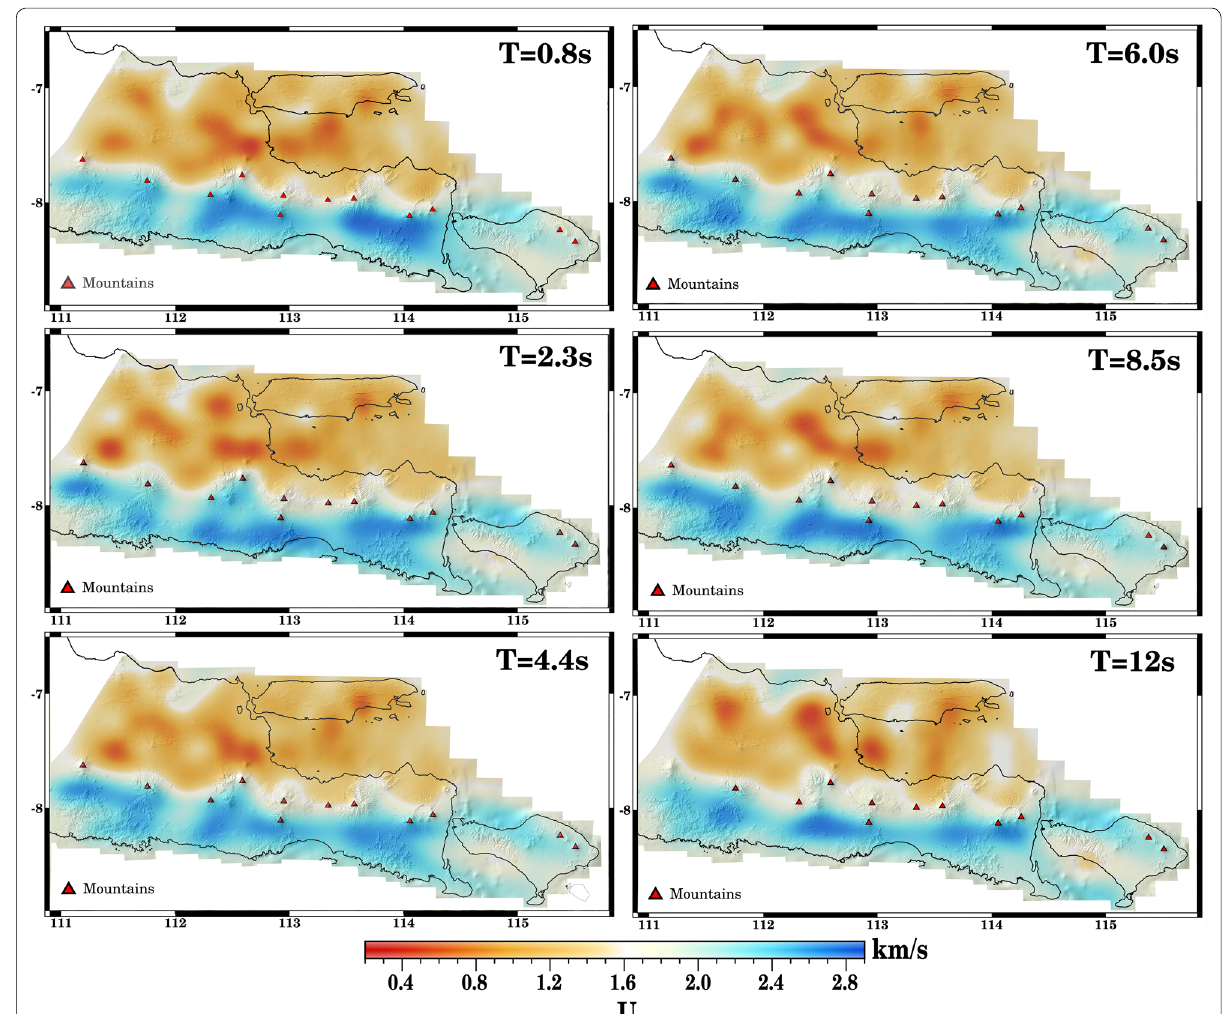
Fig. 6 Rayleigh wave group velocity tomograms from subspace inversion of ambient noise tomography data between 0.8 and 12.0